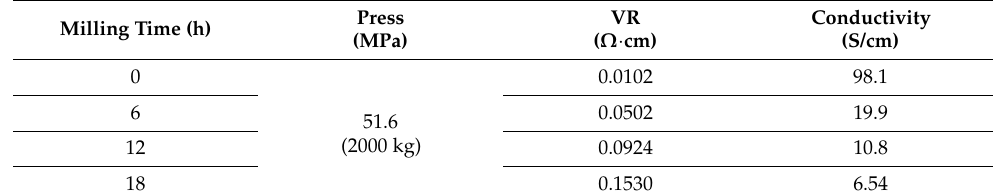
Table 2. Electric conductivity of mPCFs depending on milling time.